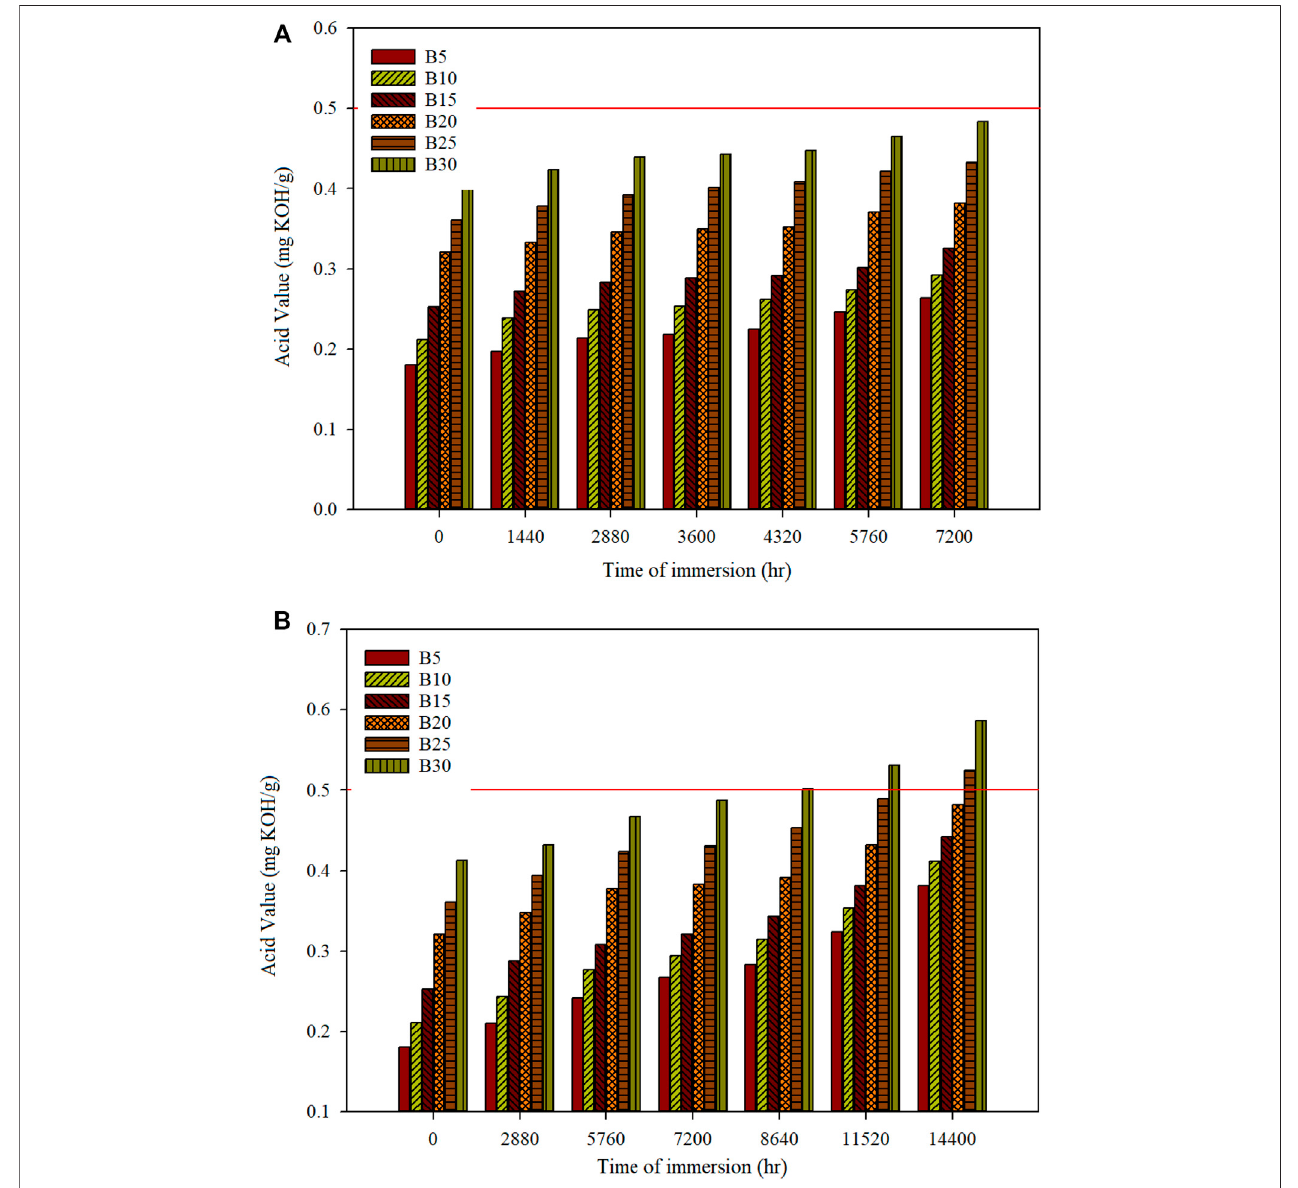
FIGURE 7 | Acid value of different biodiesel-diesel blending ratios for (A) mild steel and (B) stainless steel 316 for a speci fi c time of immersion.